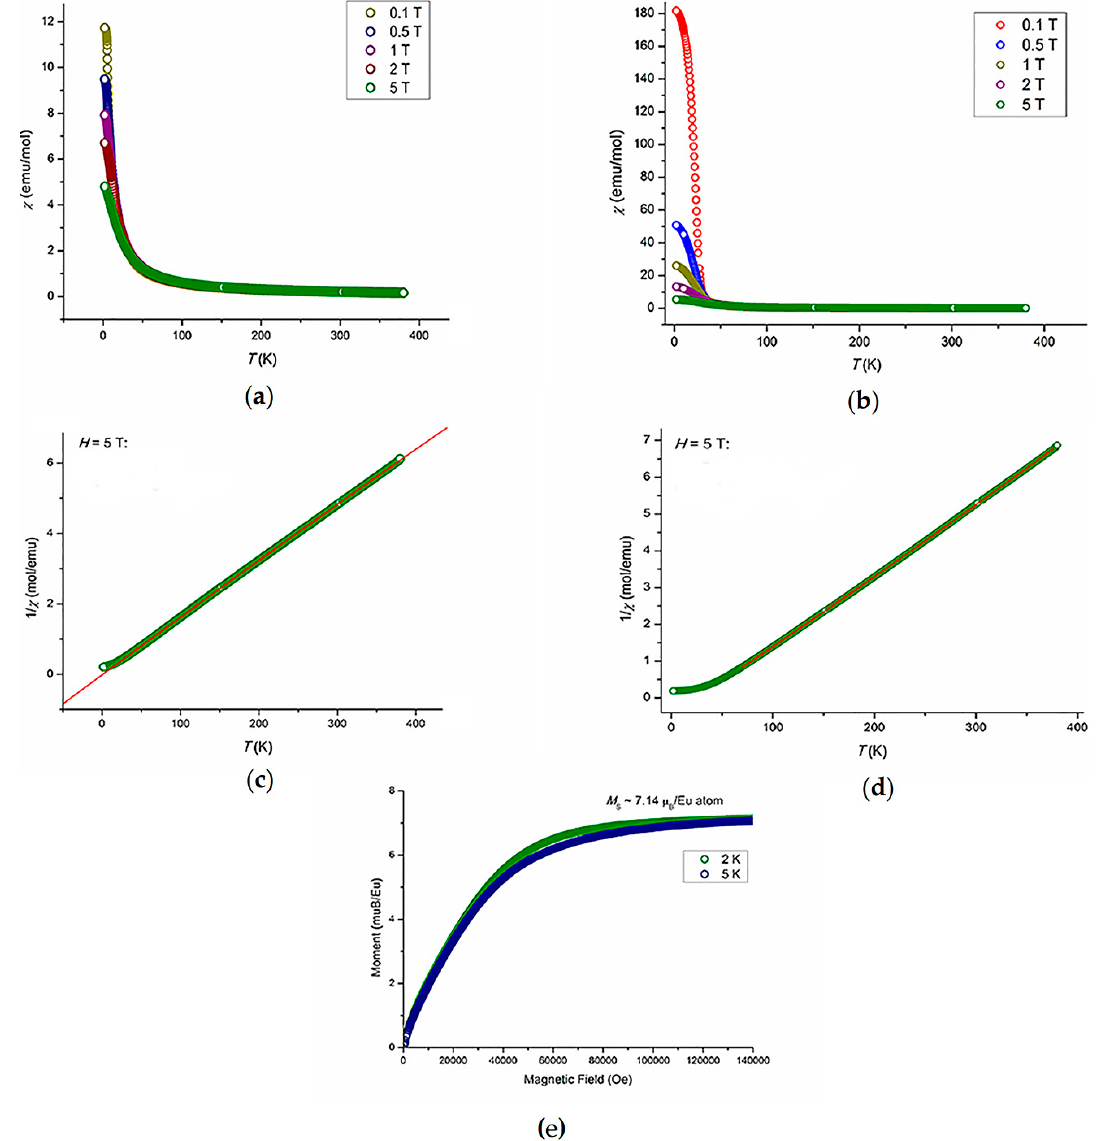
Figure 6. Magnetic susceptibility vs. temperature for ( a ) Eu 7 Cu 36 Fe 8 As 23 and ( b ) Eu 7 Cu 42 Ni 2 As 2 ; inverse magnetic susceptibility vs. temperature for ( c ) Eu 7 Cu 36 Fe 8 As 23 and ( d ) Eu 7 Cu 42 Ni 2 As 2 ; ( e ) magnetization vs. field for Eu 7 Cu 36 Fe 8 As 23 .